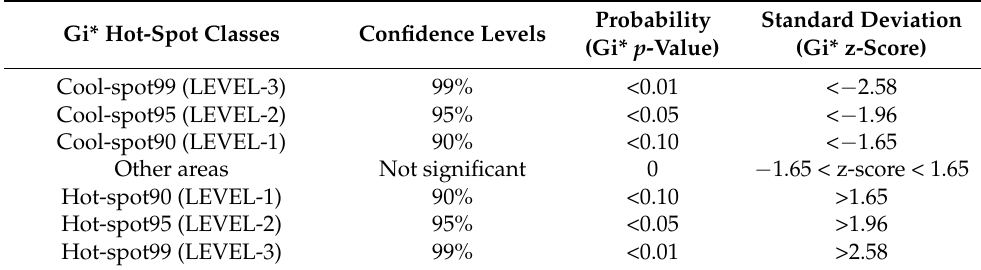
Probability Standard Deviation (Gi* p -Value) (Gi* z-Score)